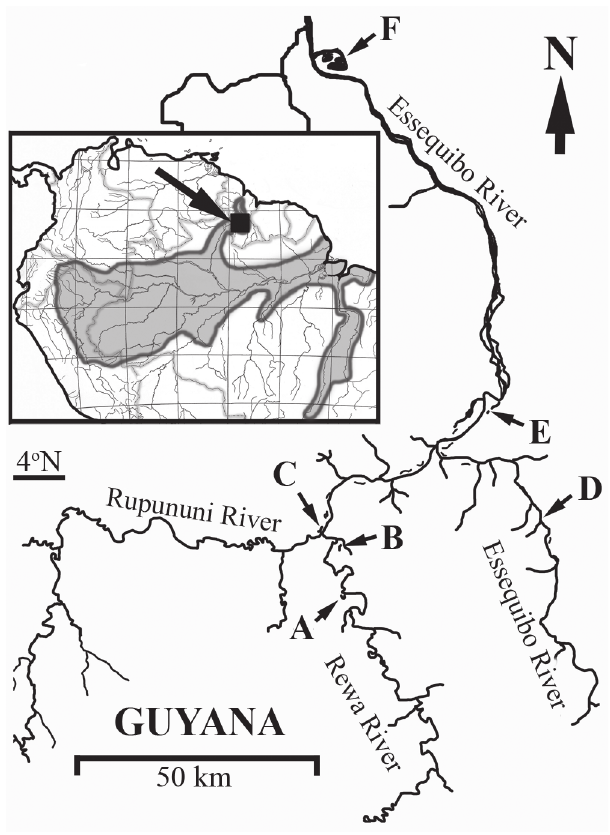
Fig. 1. Map of collecting localities for stable isotope samples from the Essequibo River basin of southwestern Guyana. Sites are as follows: a ) Banana Sucker Pond, b ) Grass Pond, c ) Makarapan Pond, d ) Small Kumaka Pond, e ) Inkapati Head Pond, and f ) Stanley Lake. Inset shows location of study area in northern South America (black box with arrow) in relation to natural distribution of the genus Arapaima (grey